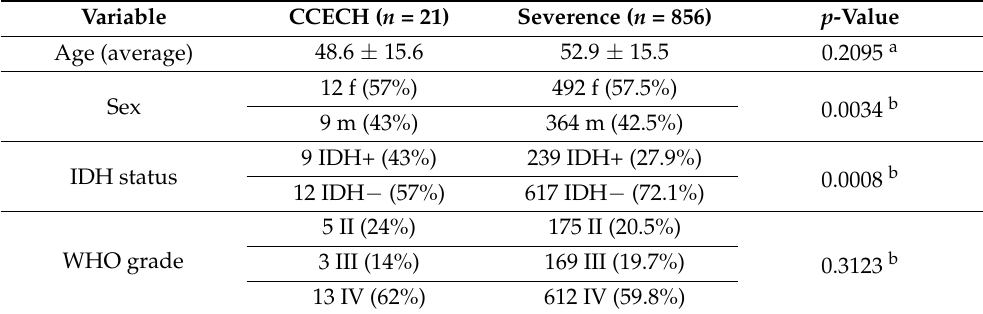
Table 1. Comparison between our sample characteristics (descriptive statistics) and Severence training dataset.